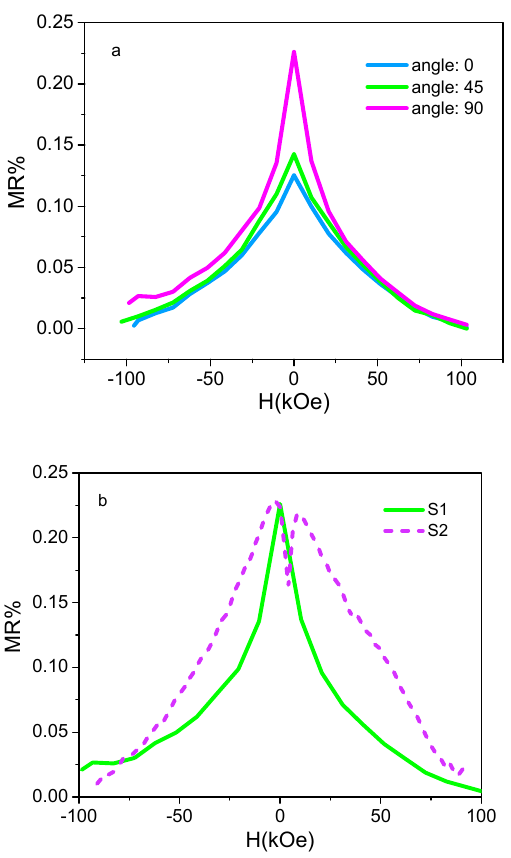
Figure 5. ( a ) AMR measurements for the S1 sample at different angles 0, 45, and 90 o between H and current; ( b ) AMR measurements for S1 and S2 samples at the angle 90 o . FMR is a very powerful experimental technique in the study of ferromagnetic thin films. In the process of resonance, the energy is absorbed from the transverse magnetic field, which occurred when the frequency matched the Larmor frequency. The Larmor frequency depends on the orientation of the material and the strength of the magnetic field. The dependence of FMR frequency on the external magnetic field for thin films can be described by the Kittel formula [55]: